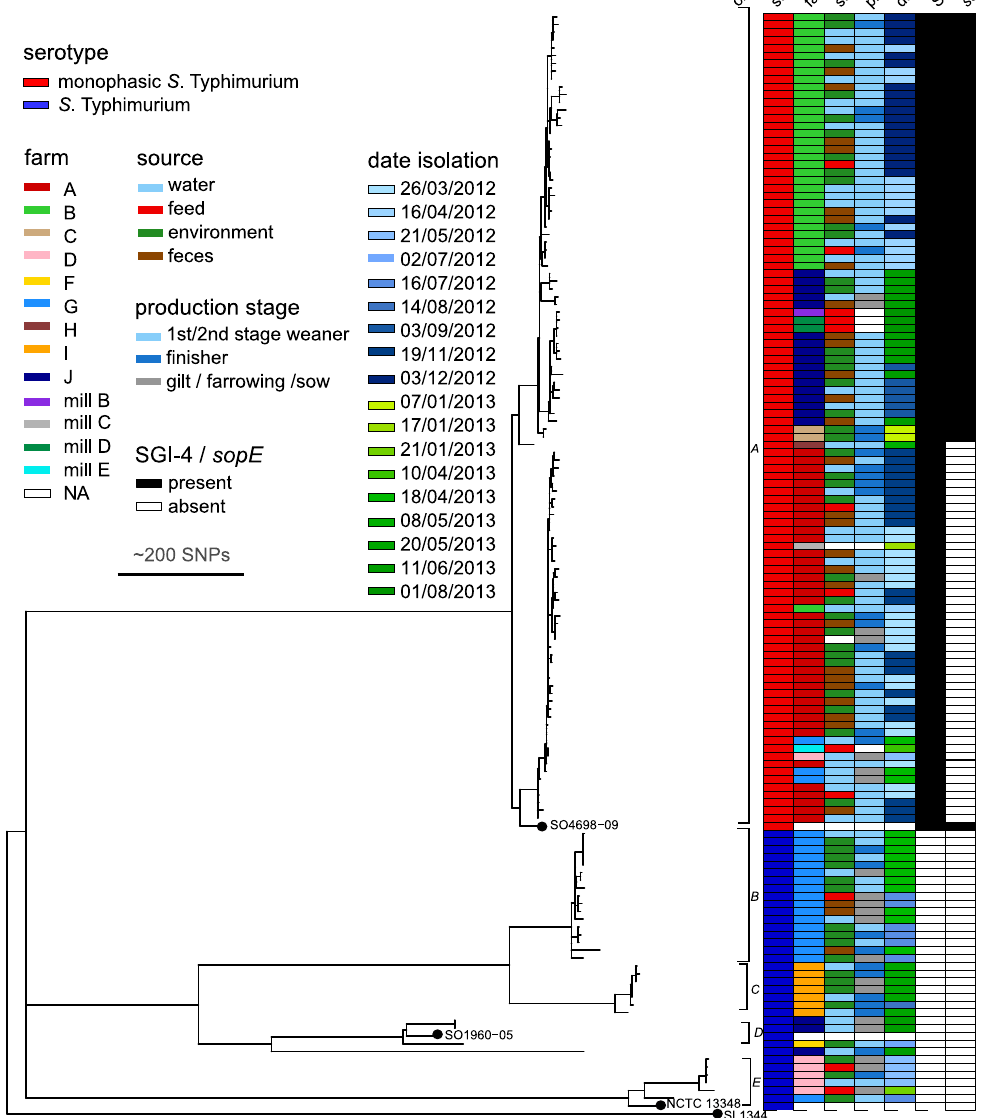
Figure 1. Maximum likelihood phylogenetic tree of isolates of S . Typhimurium and S . 4,[5],12:i:- from pig farms or feed mills in Ireland. The tree was constructed using 2,427 informative SNPs in the core genome of 138 isolates from nine farms or four feed mills with reference to S . Typhimurium strain SL1344 (accession number NC_016810.1). S . Typhimurium strains SL1344, strain NCTC13348 (phage type DT104) and strain SO1960-05 (phage type U288) were included in the tree for reference. The serotype, farm, source of isolation and stage of pig production, date and the presence of Salmonella genetic island-4 (SGI-4) and the sopE gene are indicated by filled boxes as indicated in the embedded